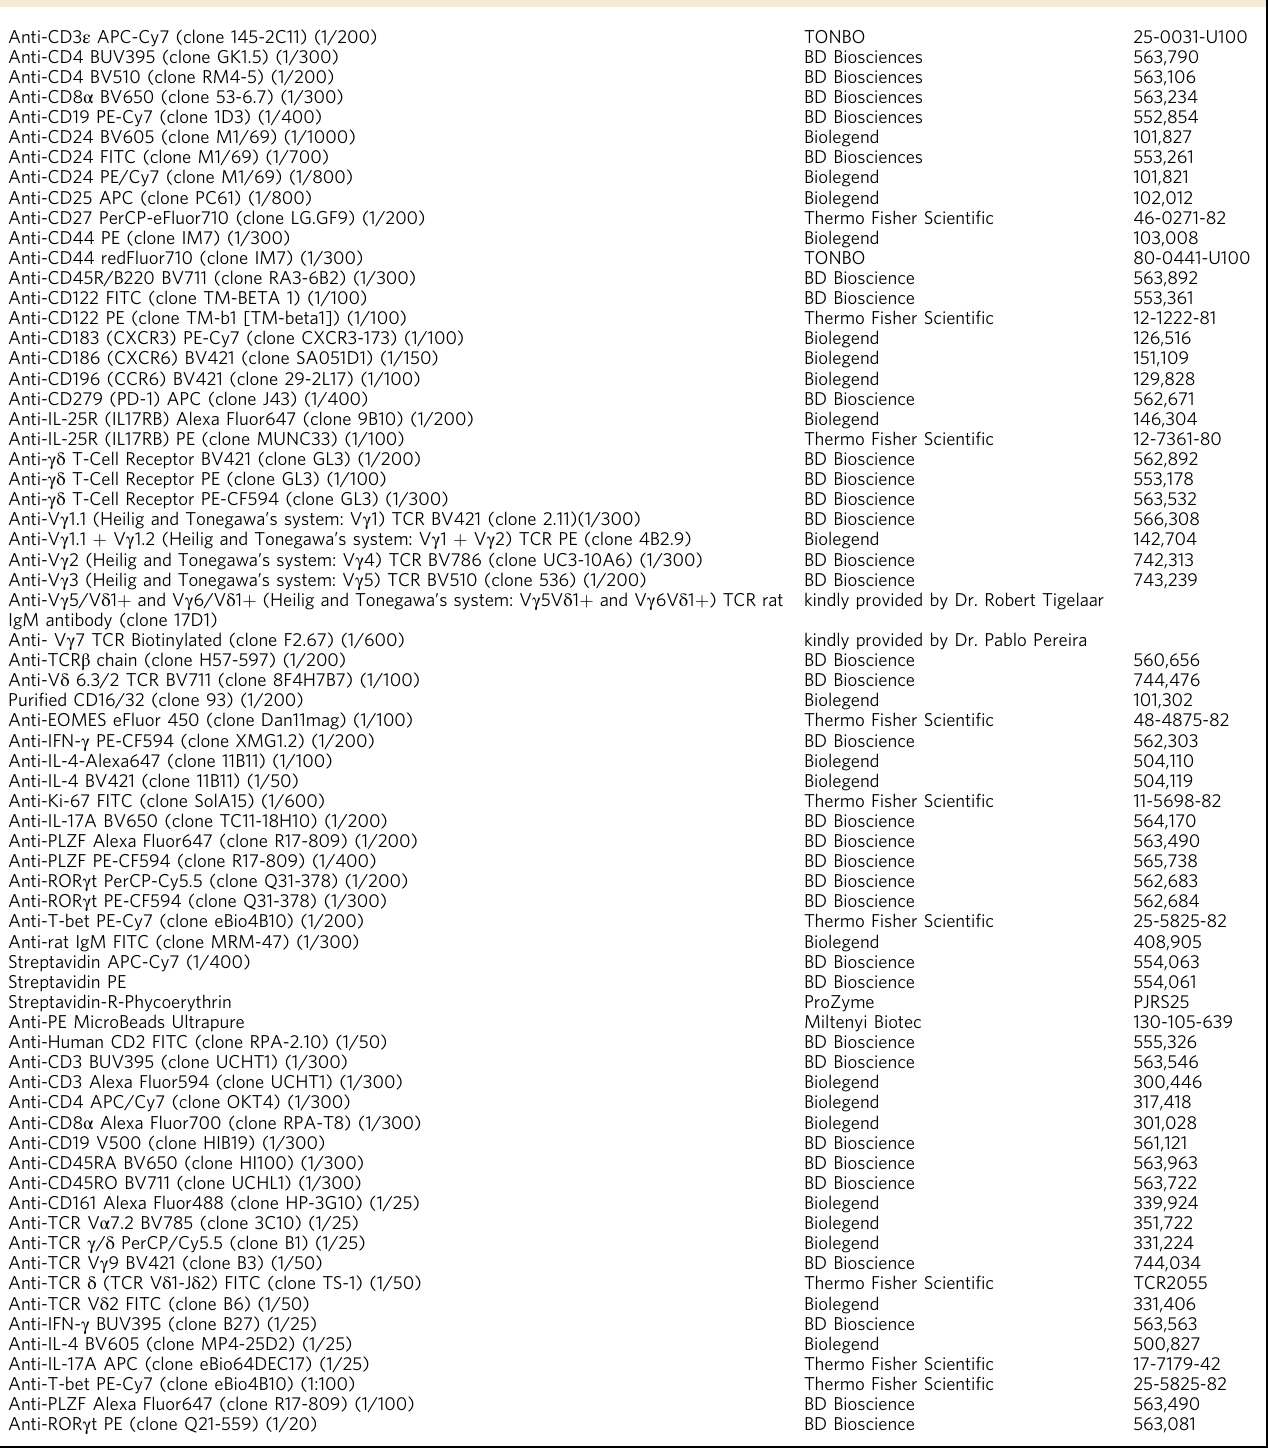
Table 1 List of antibodies and